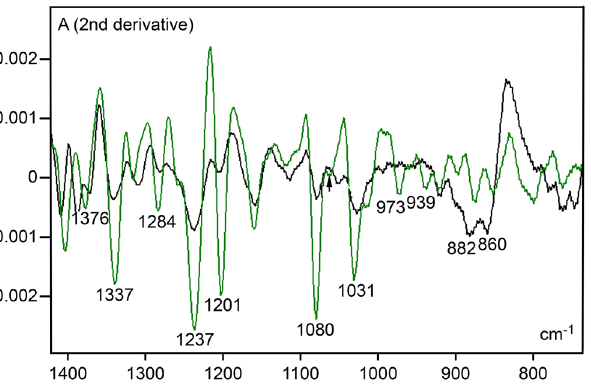
Fig 4. Savitzky-Golay ’ s 2nd-derivative spectra resolved with degree 2 and 11 smoothing points for cartilage ECM (black line) and collagen type II (green line)in the 1400 – 750 cm -1 spectral window. The arrow indicates 1062 cm -1 wavenumber position. A,